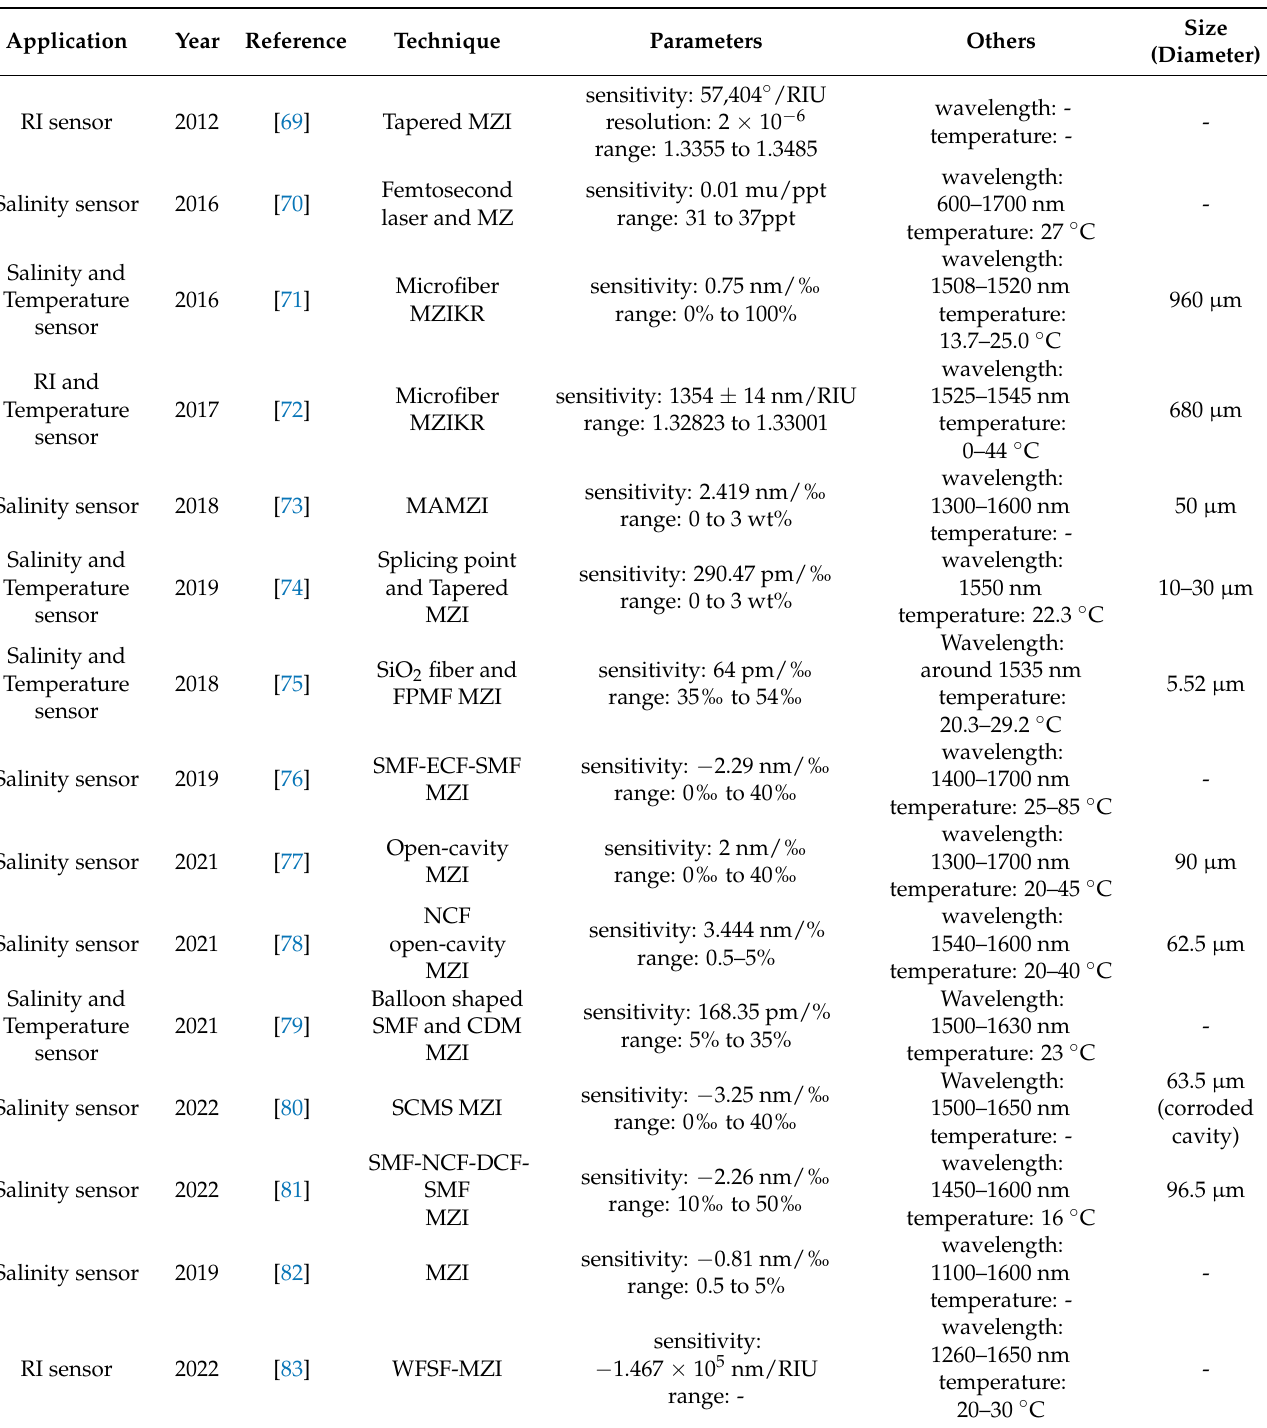
Table 5. Summary of